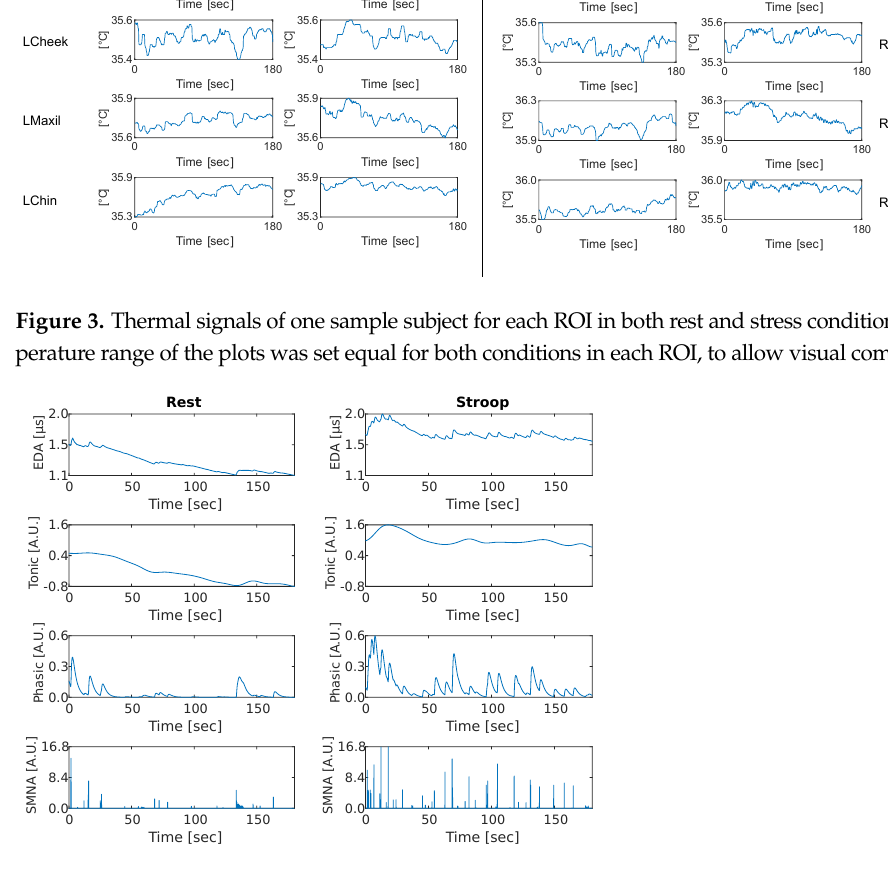
Figure 4. Application of the cvxEDA algorithm decomposition to the EDA signal of one sample subject in both rest and stress